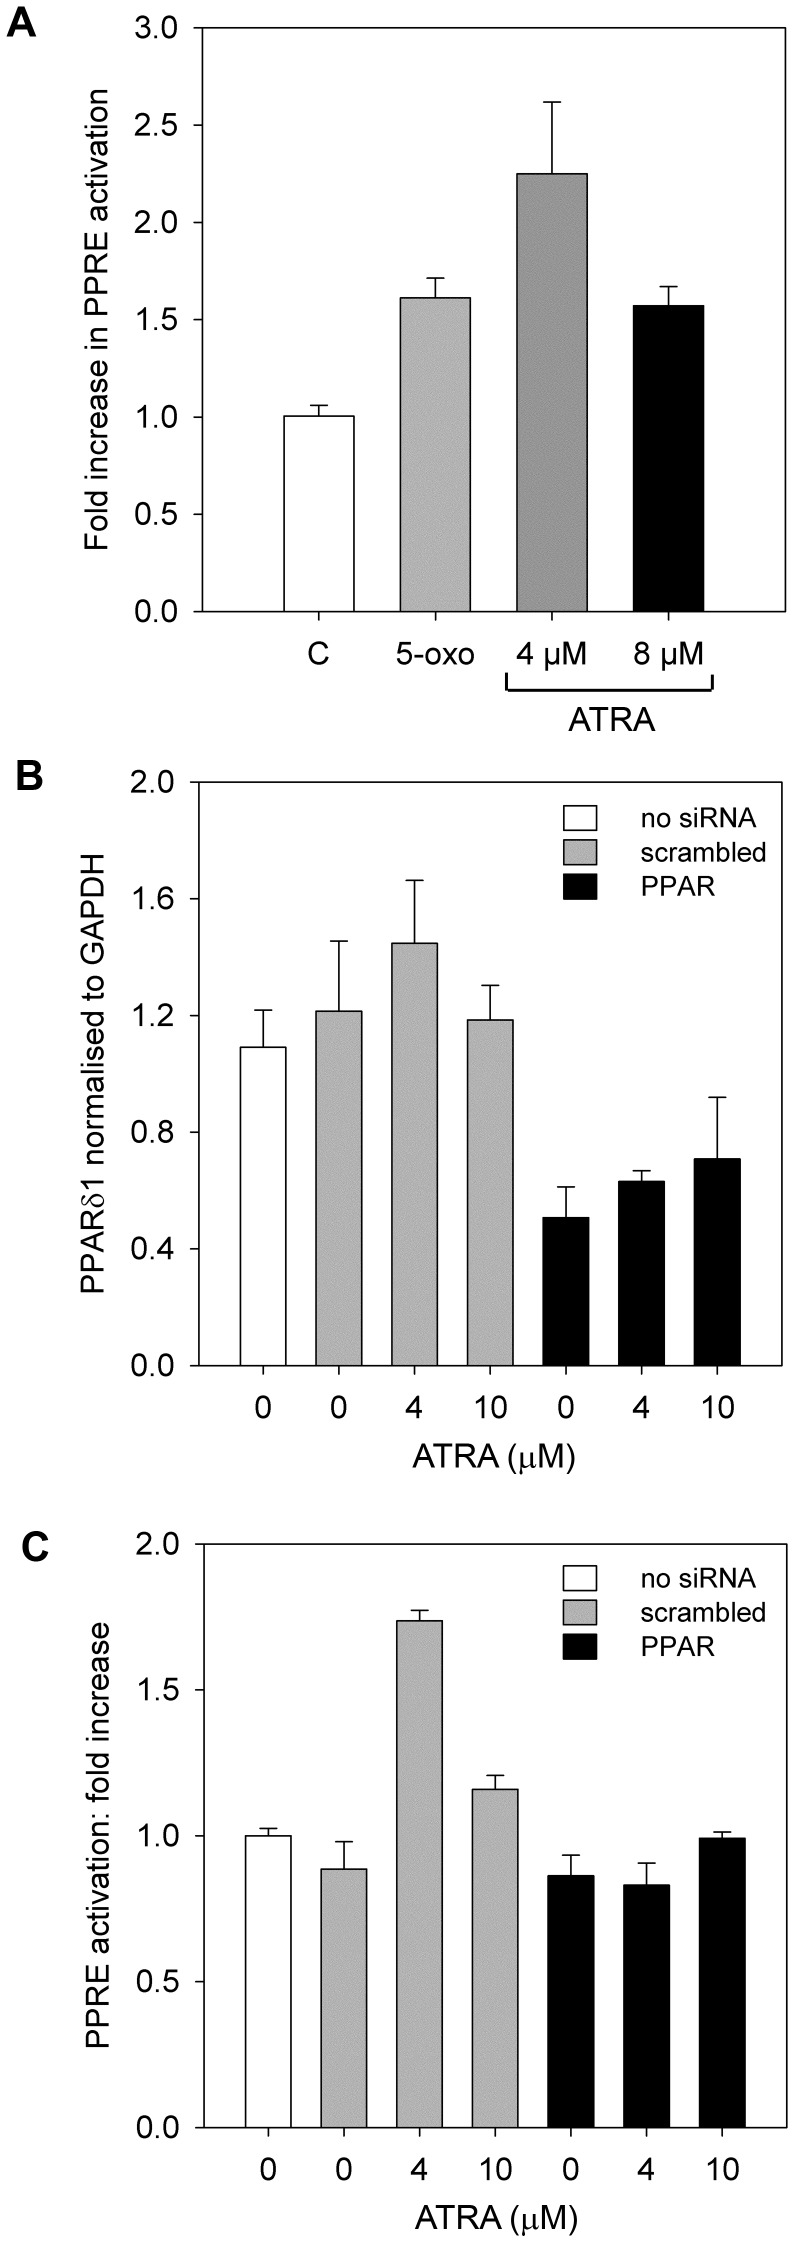
PPRE activation by PPARδ after RA treatment.(A) PPRE reporter activation in SH-SY5Y cells 2 h after treatment with control vehicle (white bar), 0.1 µM 5-oxo-ETE (light grey bar), 4 µM ATRA (dark grey bar), or 10 µM ATRA (black bar). PPRE activation was significantly higher with all 3 treatments compared to control (1-way ANOVA with contrasts: P = 0.019, P = 0.01 and P>0.001 for each treatment, respectively). (B) PPARδ1 mRNA levels in SH-SY5Y cells transfected with 10 nM PPARδ (black bars) or SCR siRNA (grey bars) for 24 h and then treated with control vehicle (0) or ATRA at 4 µM or 10 µM for 2 h. The SCR control did not significantly affect PPARδ1 expression, compared to the mock-transfected control (white bar; P = 0.566). Across treatments, PPARδ siRNA significantly decreased PPARδ1 mRNA expression compared to SCR and mock-transfected controls (1-way ANOVA, P<0.001). (C) PPRE reporter activation in siRNA-transfected SH-SY5Y cells in the presence of ATRA (4 µM or 10 µM) or control vehicle (0). PPARδ (black bars) or SCR (grey bars) siRNA had no effect on the controls (C; 1-way ANOVA with contrasts, P = 0.85). Reporter activation was significantly lower in the PPARδ siRNA-transfected cells after treatment with 4 µM or 10 µM ATRA (1-way ANOVA with contrasts, P<0.001 and P = 0.015, respectively). All error bars are±SEM.